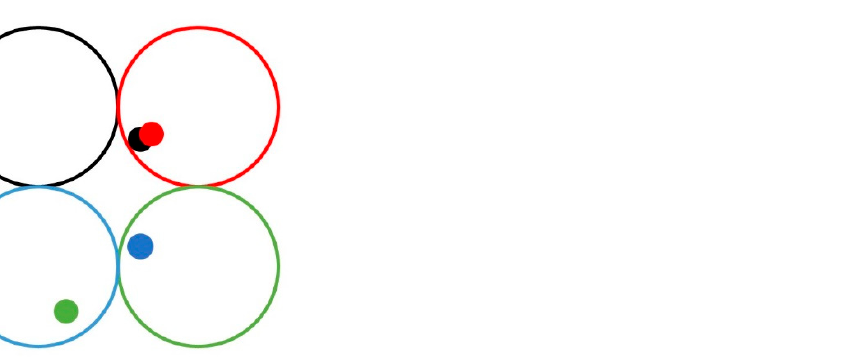
Figure 9. The dynamic range of the algorithms.